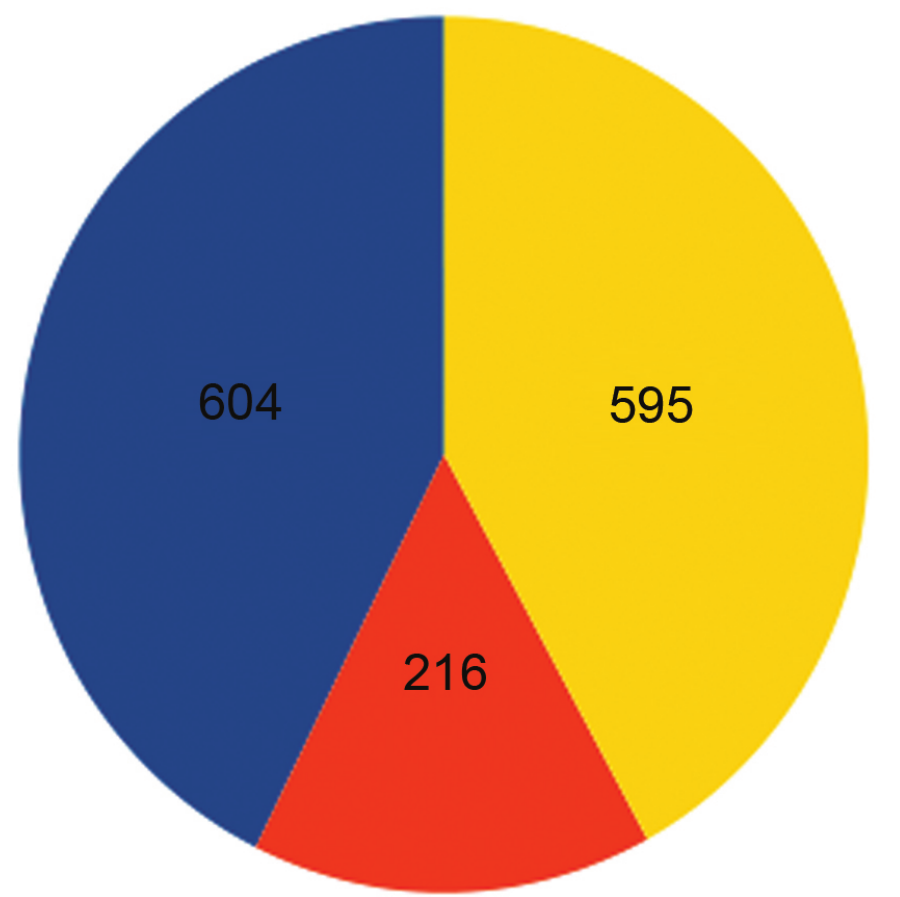
Figure 1: Distribution of mature microRNA sequence entries for miRBase (v. 21) families. The majority of families reports a miR and miR* for all (red) or at least some (blue) of the family members. Families in which only a single mature product is reported for every member are shown in